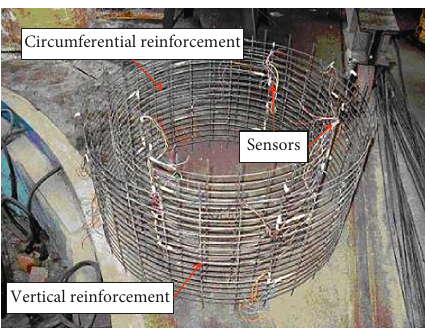
Figure 6: Normal distribution of concrete compressive